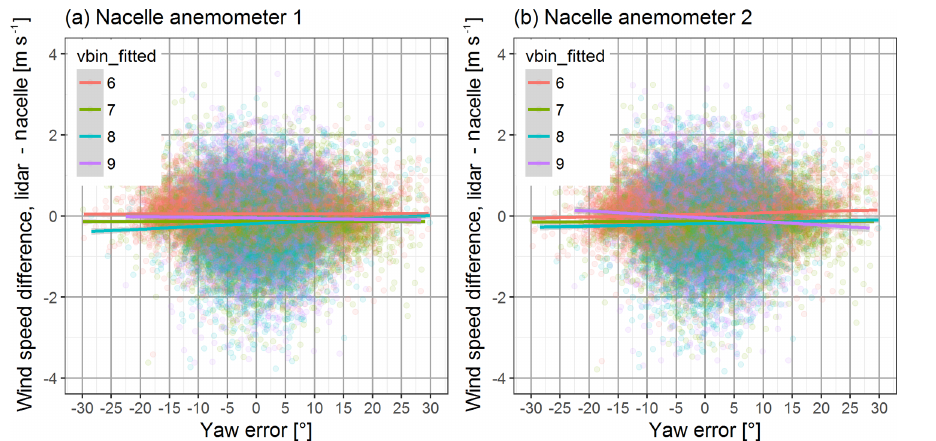
Figure 13. Wind speed difference between a ground-based measurement in front of the turbine and the cup anemometers on the nacelle after the correction with the linear model. The lines represent linear regressions for the respective wind speed bin. The dependency on yaw error is significantly reduced.